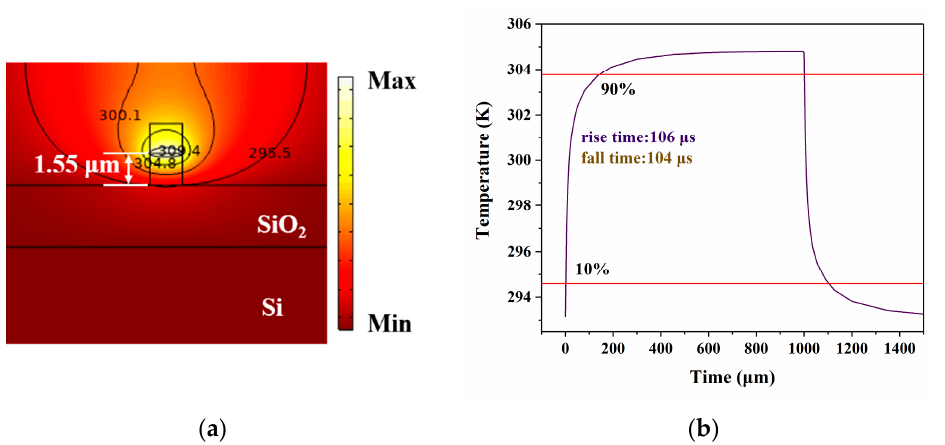
Figure 9. Switching characteristics with silicon substrate. ( a ) Thermal field diagram; ( b ) time response of the optical switch.